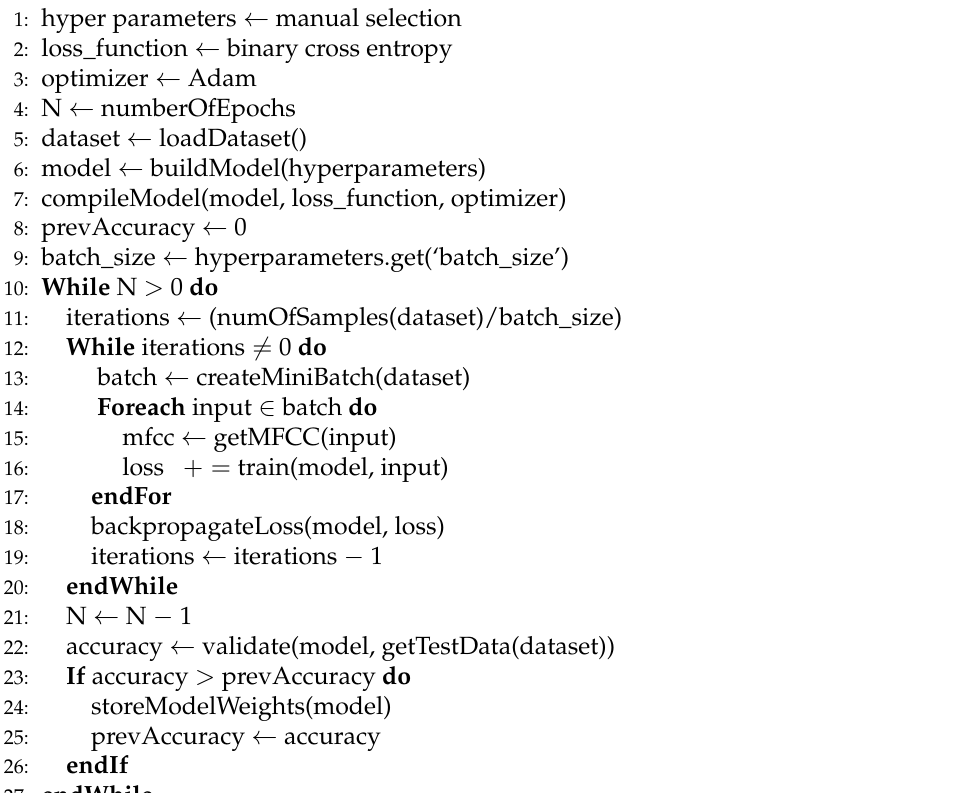
Algorithm 1 : Attention-based Bi-GRU architecture for audio